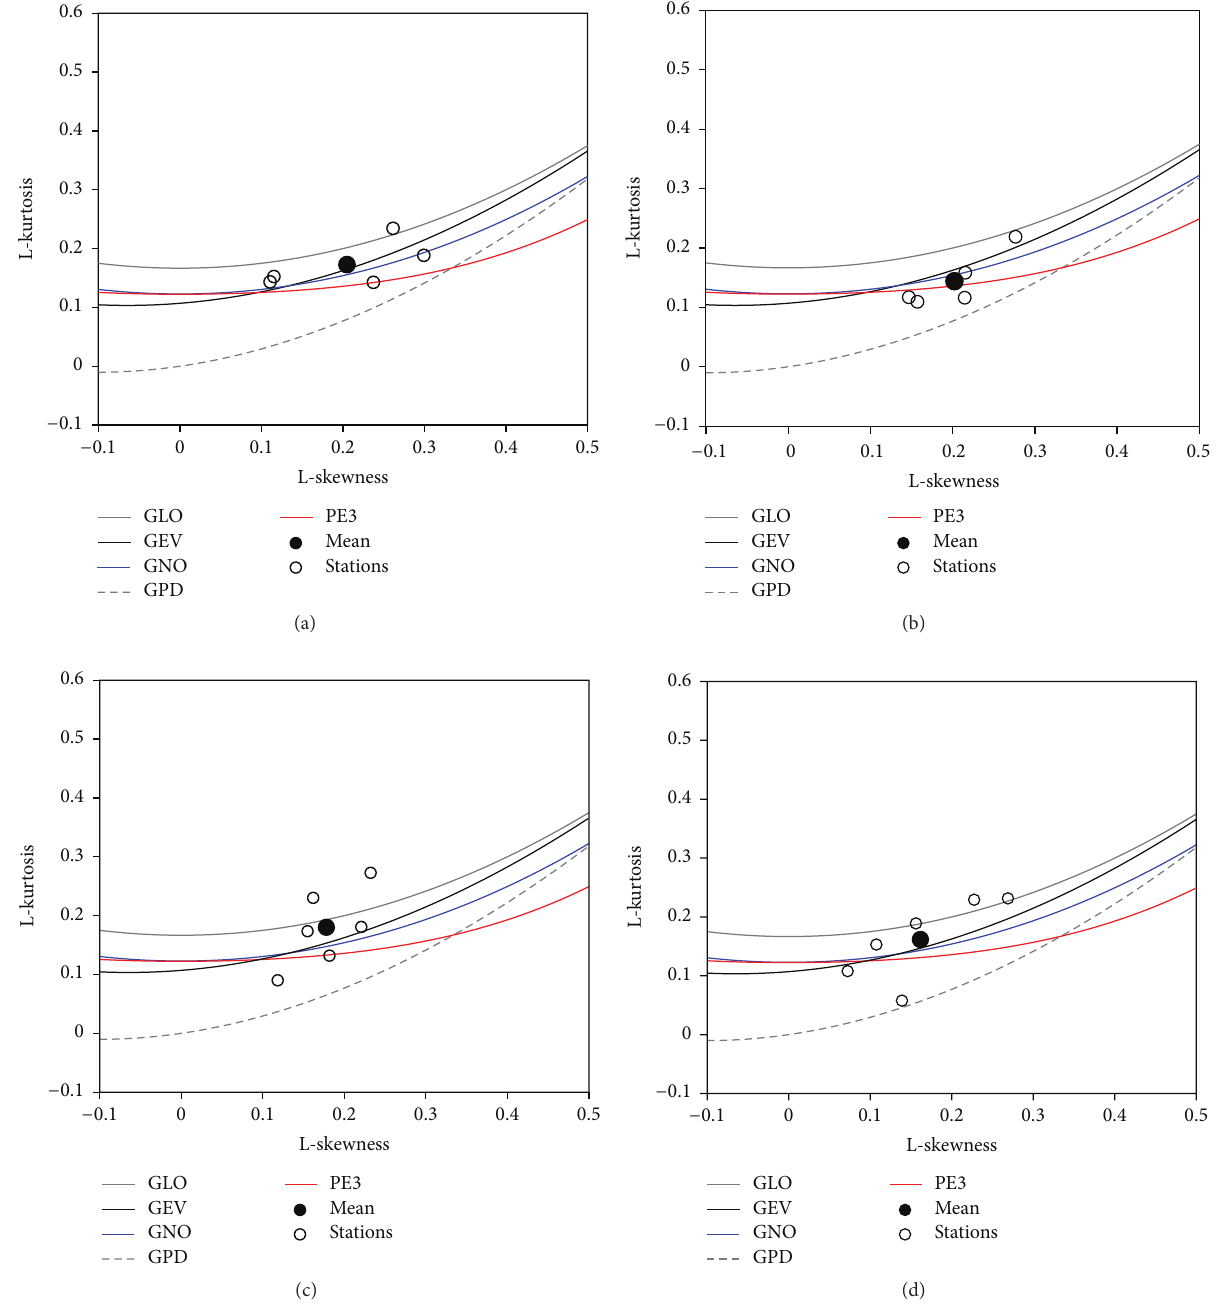
Figure 8: L-moments ratio diagram for subregion 1 (a), subregion 2 (b), subregion 3 (c), and subregion 4 (d) in the WRB. The circle point and solid black point represent the L-moments ratios of each station and the average regional L-skewness and L-kurtosis, respectively.